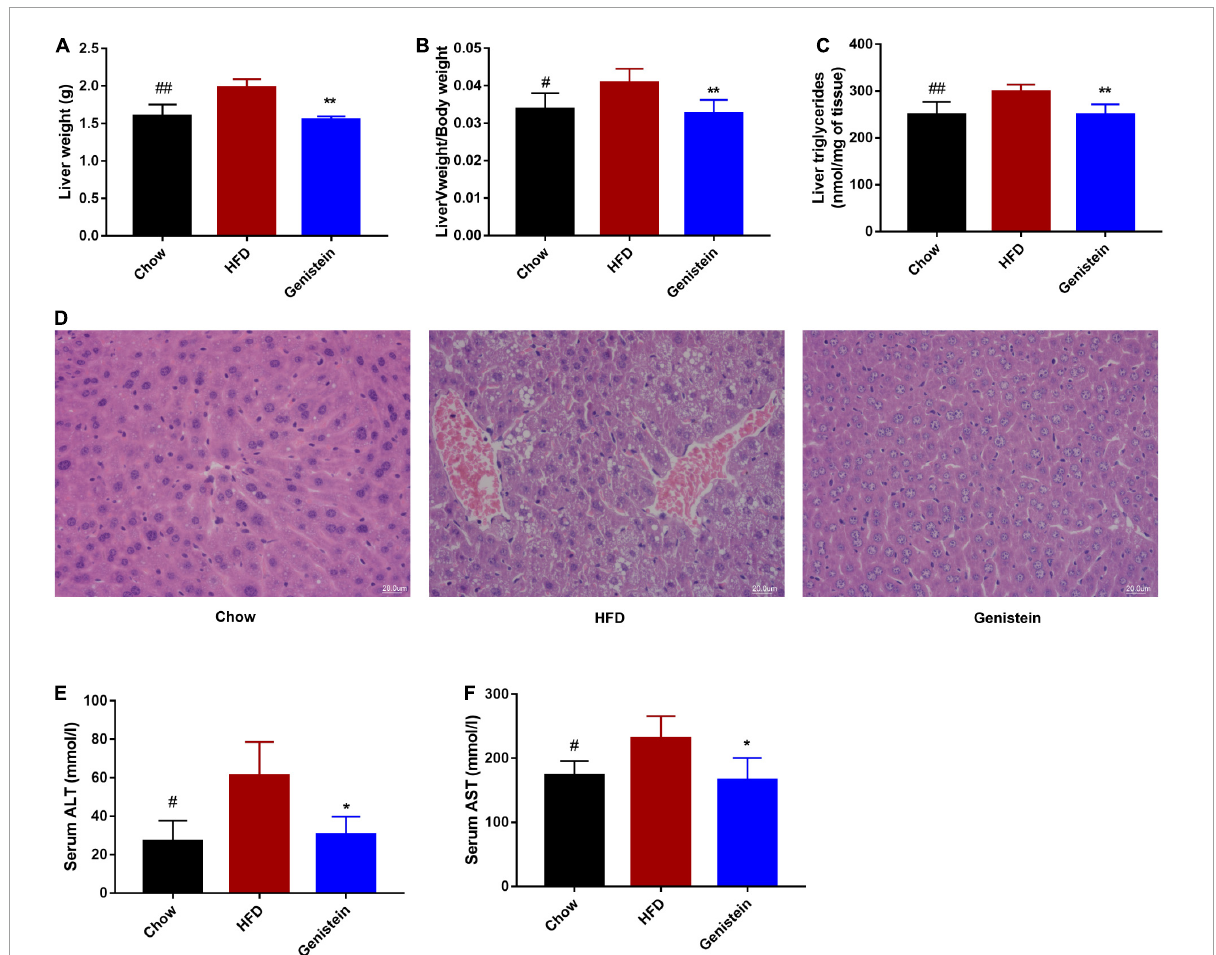
FIGURE5 Genistein prevents fatty liver induced by HFD (A) Live tissues were harvested and weighted during necropsies. (B) The ratio of liver weight to body weight. (C) The content of triglycerides in liver tissues. (D) Representative images of liver H&E staining of liver tissues. Scale bars, 20 µ m. (E,F) Plasma ALT and AST levels. Data are presented as means ± SEM; n = 4–5 mice/group. # p < 0.05 and ## p < 0.01 for Chow vs. HFD. * p < 0.05 and ** p < 0.05 for Genistein vs.